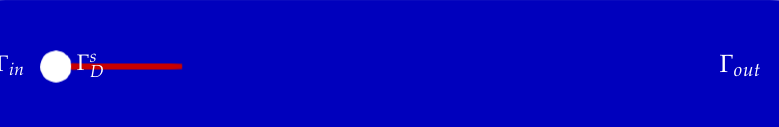
Figure 2. Reference configuration of the benchmark test case. The solid is depicted in red, while the fluid domain is in